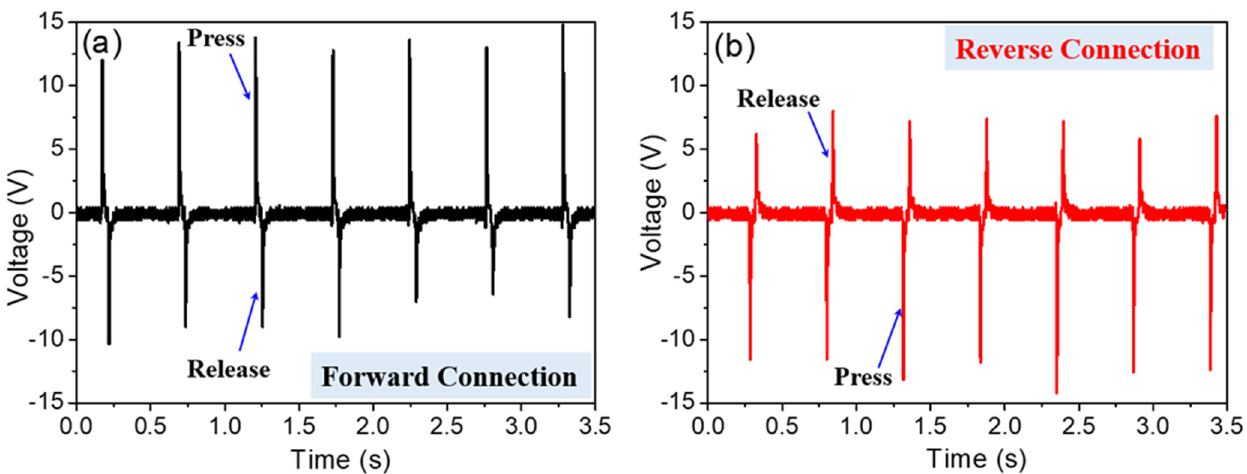
Figure 5. Output voltage signals from a-PVDF nanogenerator with ( a ) forward and ( b ) reverse electrical connections with measuring instrument.